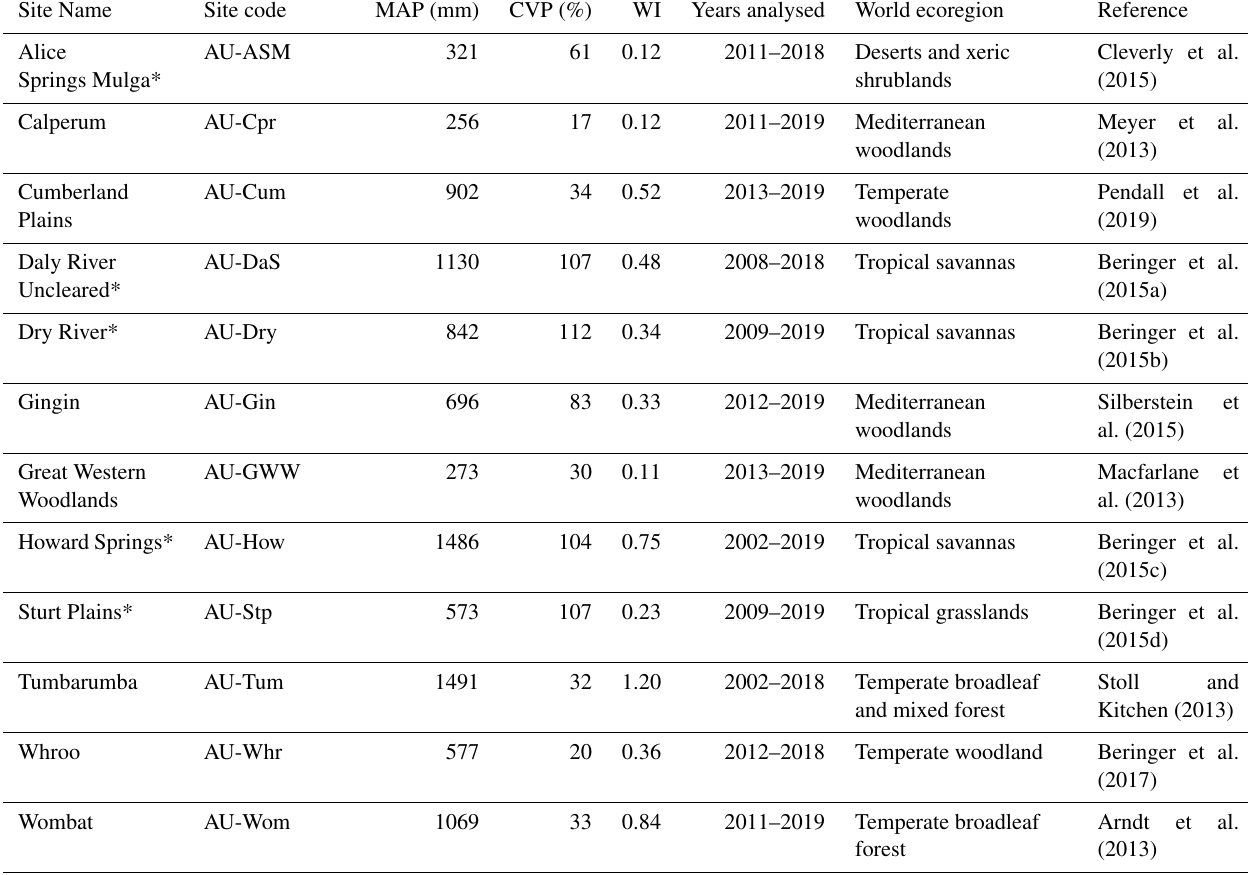
Table 1. Site information for all sites included in the analysis. MAP is the mean annual precipitation at the site. CVP is the coefficient of variation in precipitation. WI is a wetness index of MAP over mean annual reference evapotranspiration. MAP, CVP, and WI are calculated from the WorldClim dataset, which covers 1970–2000 (Fick and Hijmans, 2017; Trabucco and Zomer, 2018). “Years analysed” corresponds to the full years of data available for analysis, inclusive. “World ecoregion” is the biome classification of each site, which is based on climatic regime and ecological structure, among other criteria (Olson et al., 2001; Beringer et al., 2016). Asterisks indicate sites that are part of the NATT. Litchfield was initially included in the analysis but was discarded due to the short time series available. All other sites are grouped as the SAWS. Data were obtained from the OzFlux Data Portal (http://data.ozflux.org.au, last access: 21 September